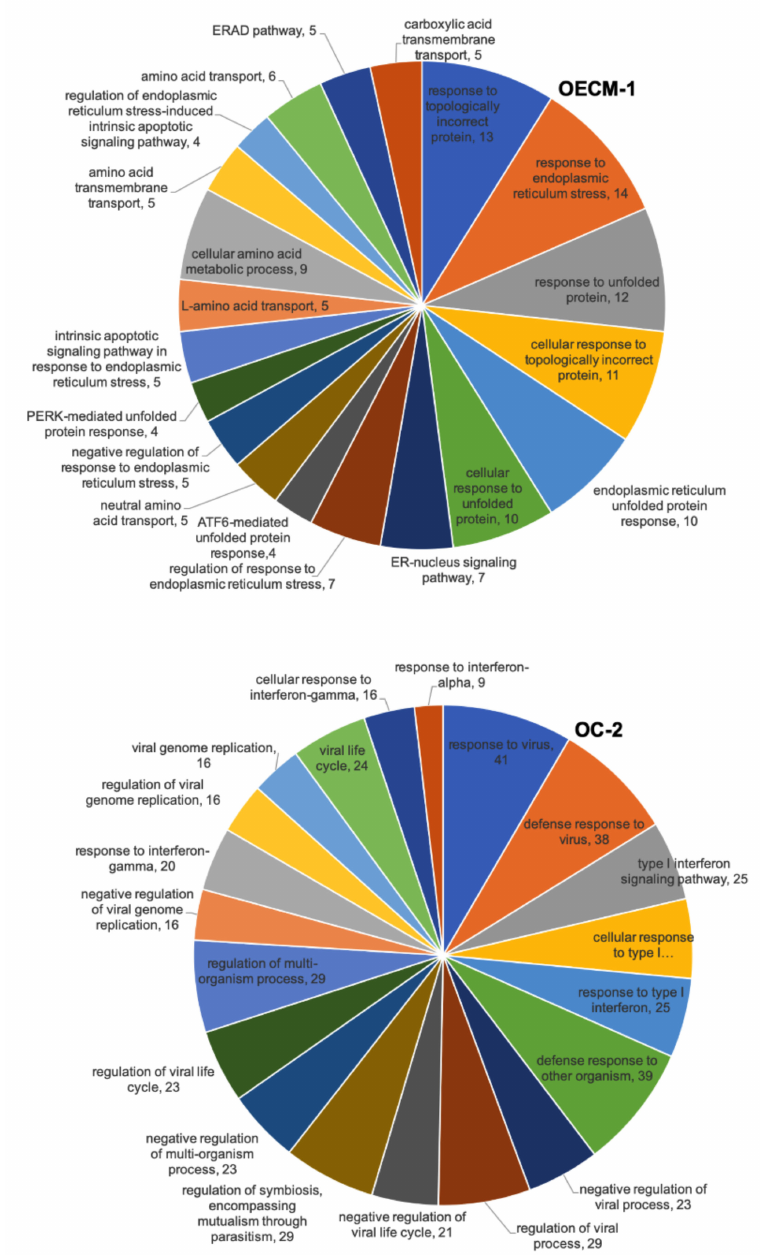
Figure 5. RNA sequencing showing the biofunction of DEGs in CD47-overexpression in the OECM-1 and OC-2 cell lines according to DAVID biological process analysis. The numbers represent the number of genes involved in the biological